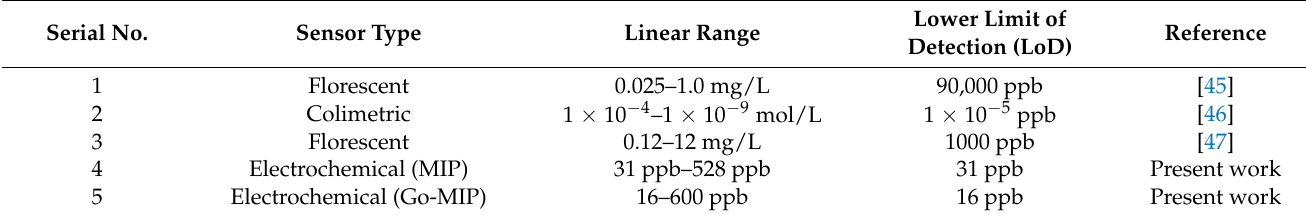
Table 1. Comparison of present work with sensors cited in the